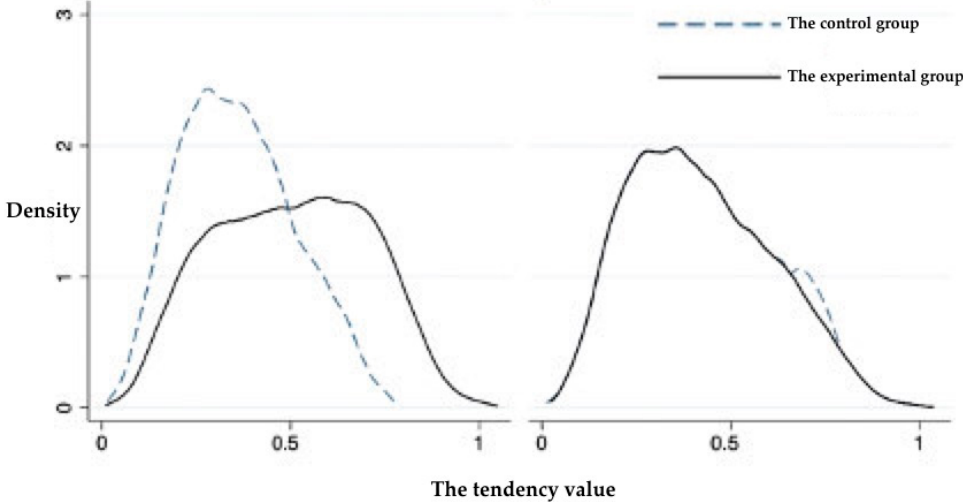
Figure 5. Matching of the kernel densities between the experimental and control groups.